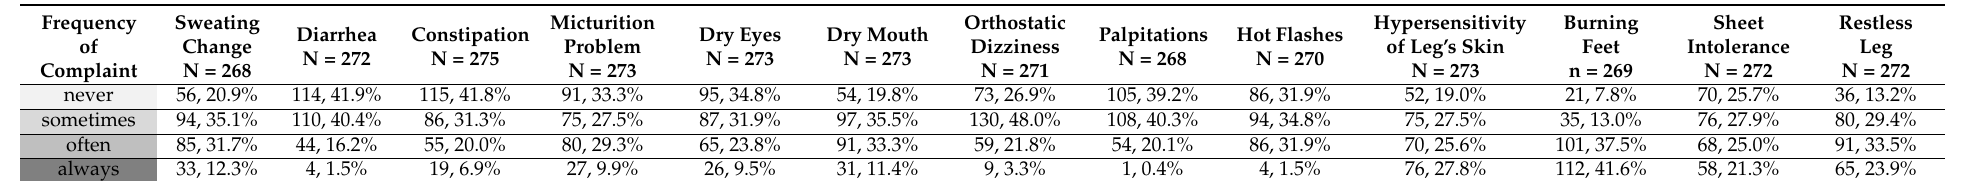
Table 7. Patients with SFN without a (potentially) pathogenic ICG/VGSC variant reporting Small Fiber Neuropathy Symptom Inventory Questionnaire (SFN-SIQ)